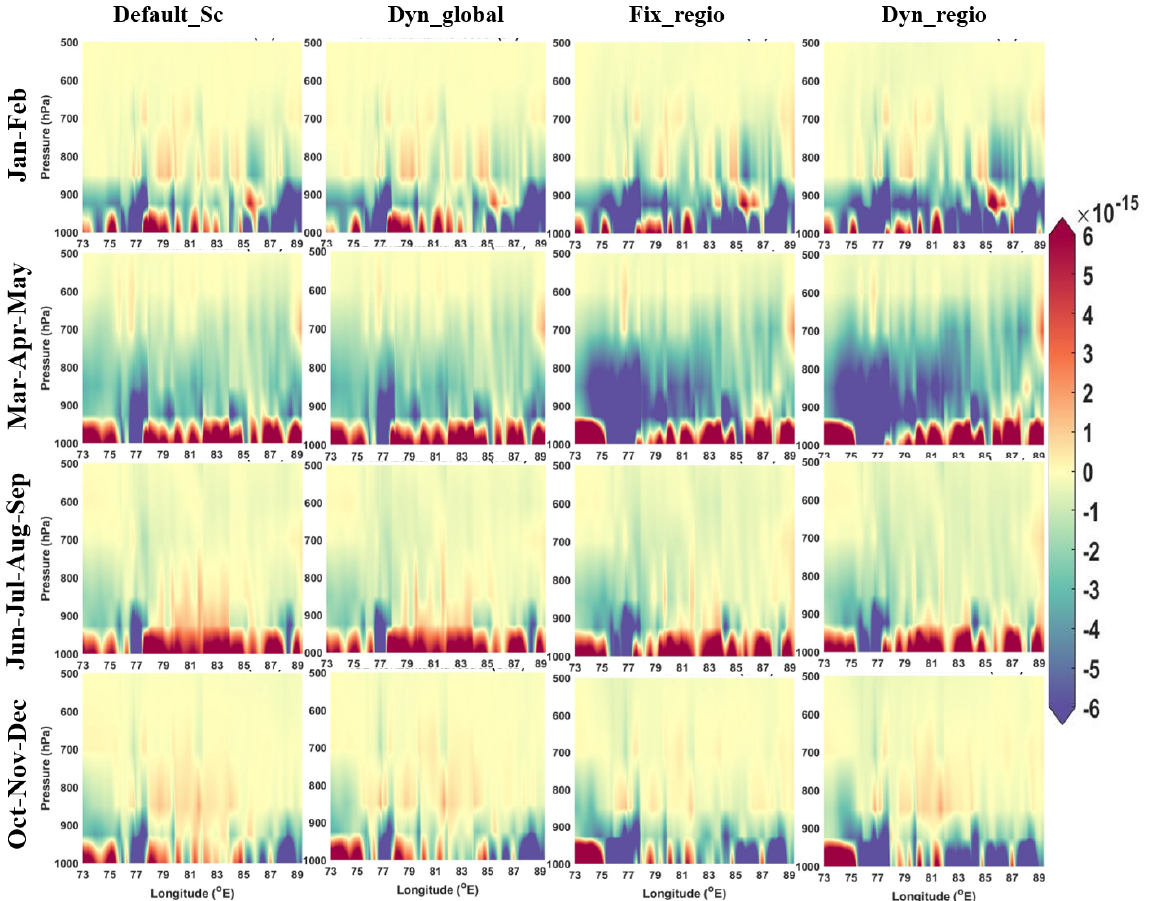
Figure 6. Seasonal distribution of the lateral advection (kgkg − 1 s − 1 ) of BC over the IGP for four distinct